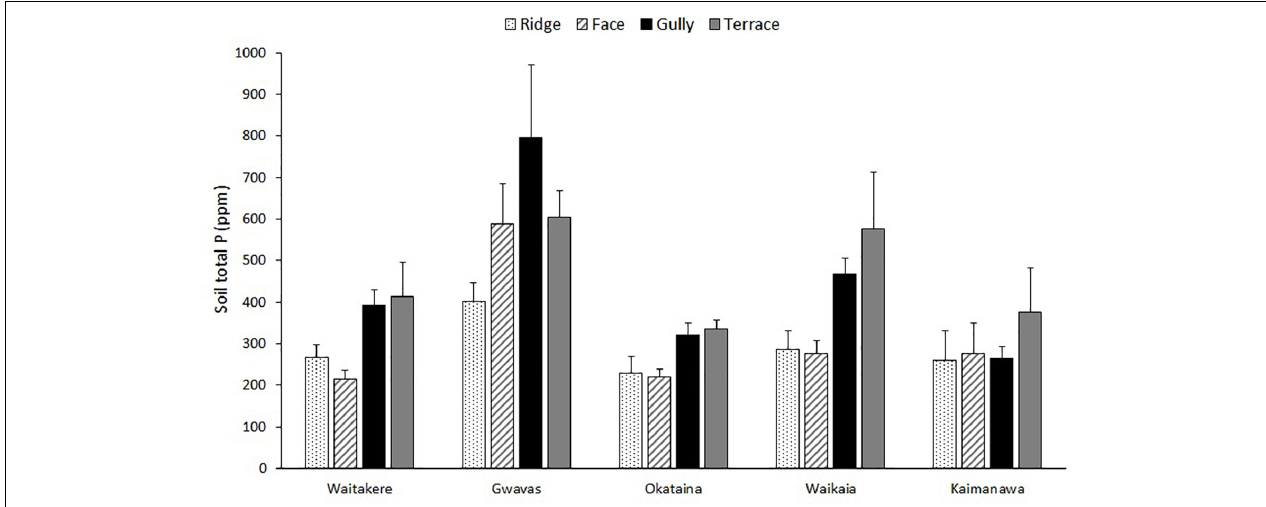
FIGURE 3 | Effect of topography on total P of uppermost 15 cm of mineral soil, at five localities differing widely in macroclimate. Graph shows means ( ± 1 se) of measurements at three to six replicate ridges, terraces and gullies and up to six replicate faces.